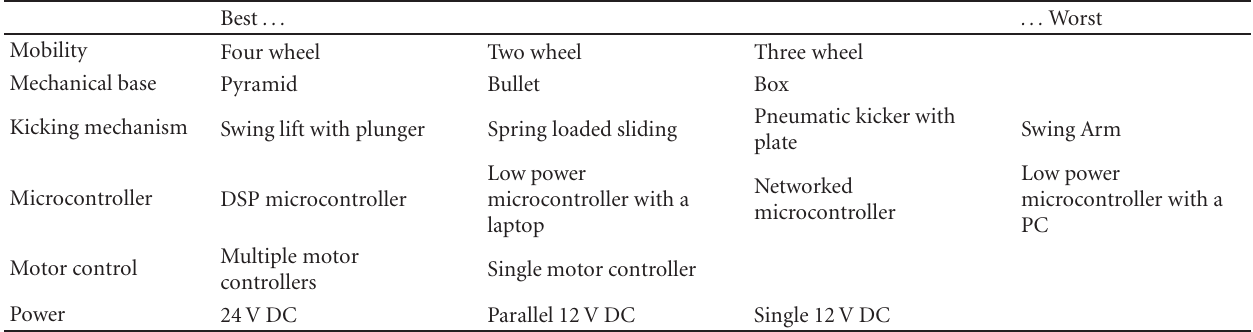
Table 1: Ranking of the individual design modules. Best